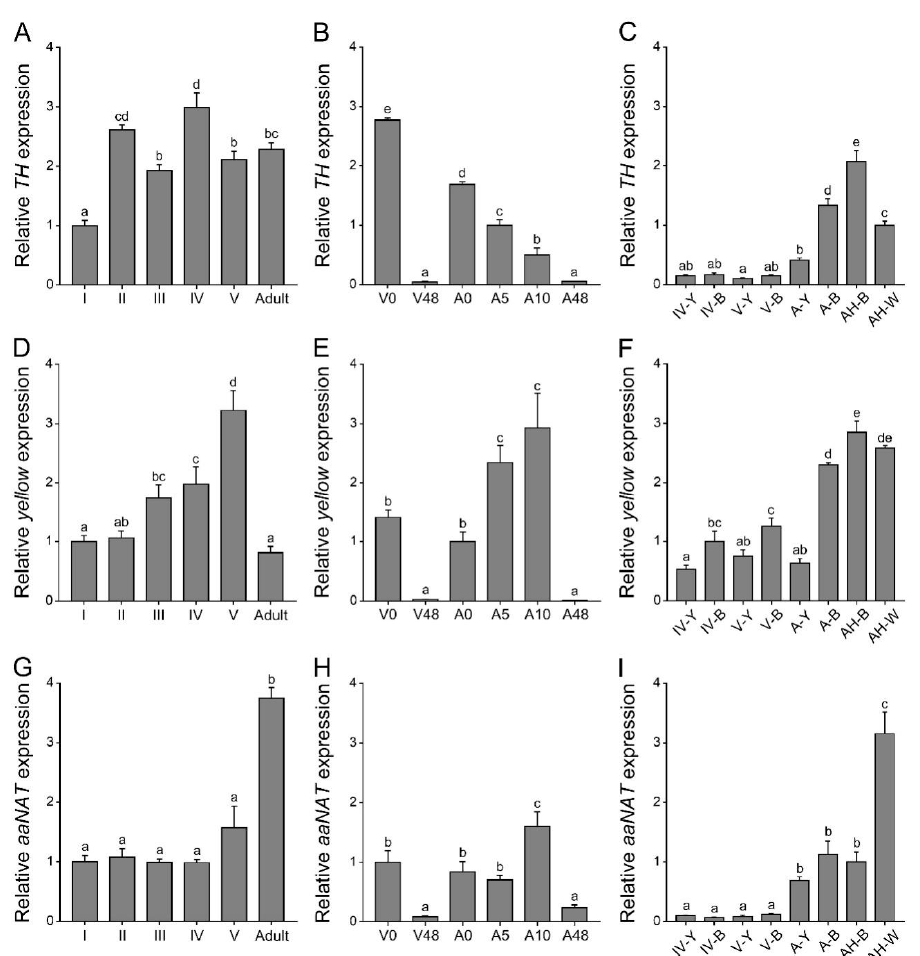
Figure 1. Expression profiles of TH, yellow , and aaNAT in P. biguttatus . ( A , D , G ) Relative expression levels of TH , yellow , and aaNAT were detected by quantitative real-time PCR at di ff erent developmental stages. All these nymphs and adults have completed the pigmentation process before RNA extraction. ( B , E , H ) Relative expression levels of these three genes at di ff erent pigmentation time points. ( C , F , I ) Relative expression levels of these three genes in body regions with di ff erent color patterns from di ff erent developmental stages. I–V, the first- to fifth-instar nymphs; A, adults; 0, 5, 10, and 48 h of the corresponding instar nymphs; Y, the yellow annulation of the leg; B, the black region of the leg; H-B, the black region of the hemelytra; H-W, the white spot of the hemelytra. Expression levels were normalized to the expression of EF1 α of P. biguttatus . Data are shown as the mean values ± SE (error bars) ( n = 3). Di ff erent letters (a, b, c, d, and e) on the error bars indicate statistically significant di ff erences (one-way ANOVA analysis, p < 0.05).